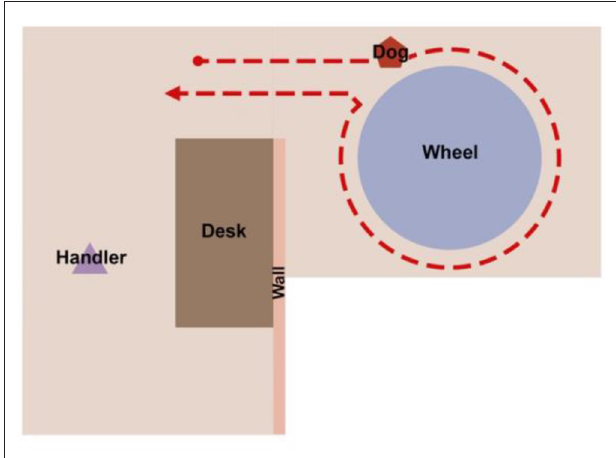
FIGURE 1 | A diagram of the wheel room setup and the positions of the handler and the dog. The handler is out of sight of the dog while the dog searches on the